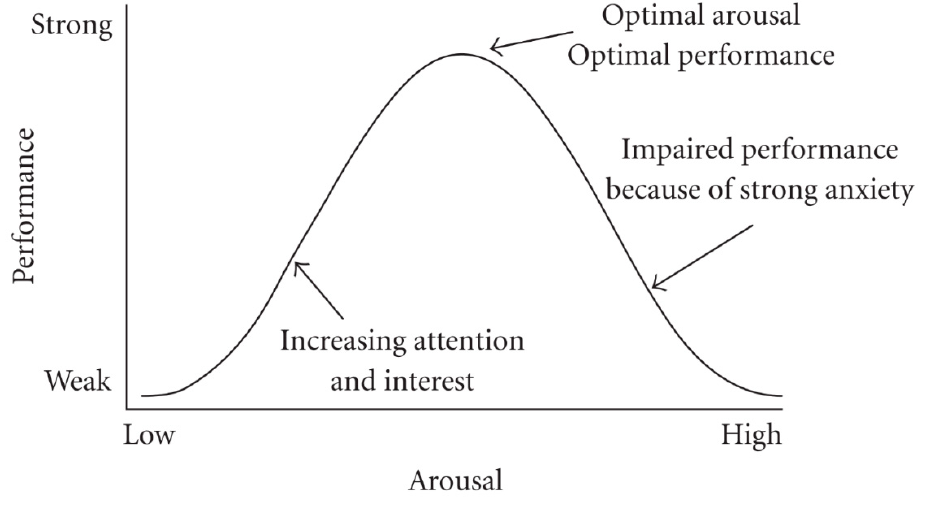
Figure 1. Hebbian version of the Yerkes–Dodson law (see [9]).